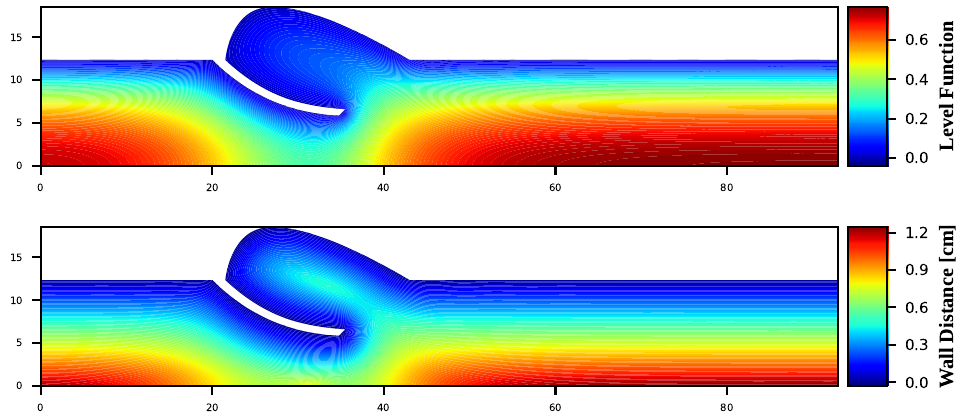
Figure 5. Level function and associated wall distance, computed using a PINN, trained to solve the Eikonal